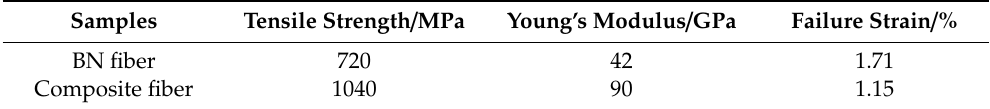
Table 2. Mechanical properties of two ceramic